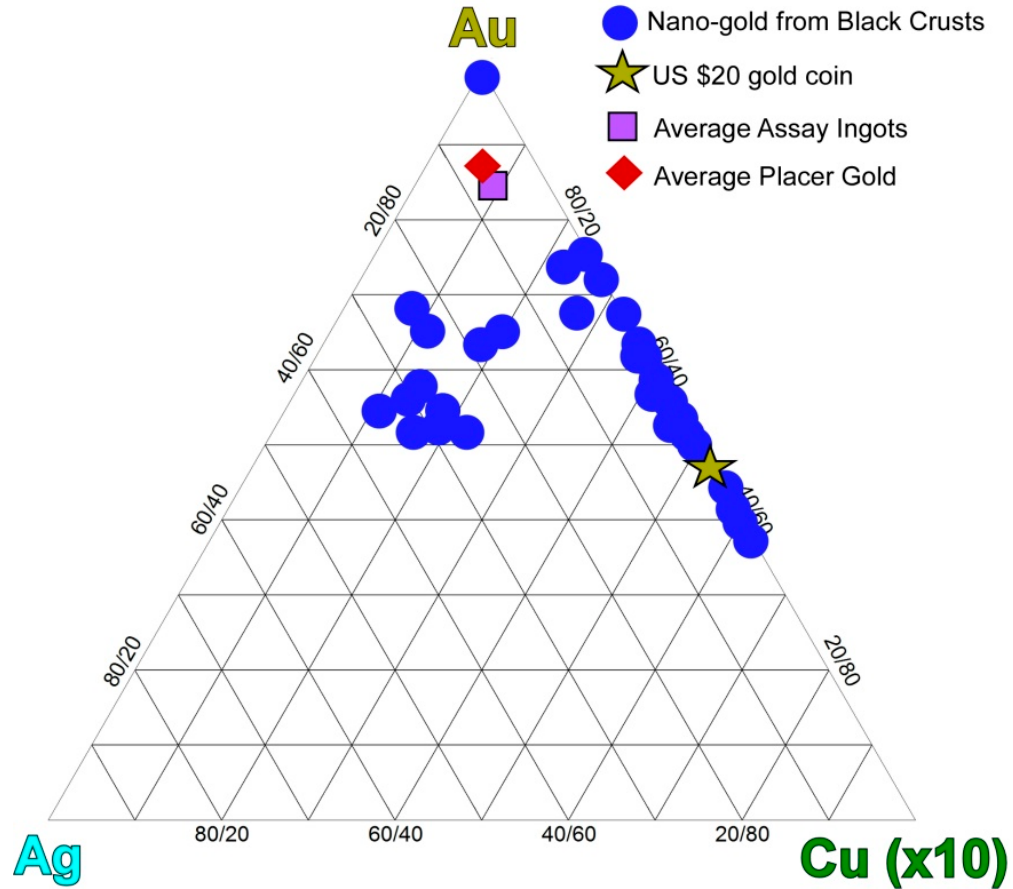
Figure 7. Ternary plot of fifty-six chemical analyses of nanoparticulate gold alloys from black crusts (blue dots). Note the exaggeration of the Cu axis used to magnify variations of this element relative to the other two. The composition of an 1857-S US $20 gold coin (yellow star), average placer gold (red diamond), and assay ingots (purple square) from the SS Central America are shown for reference.